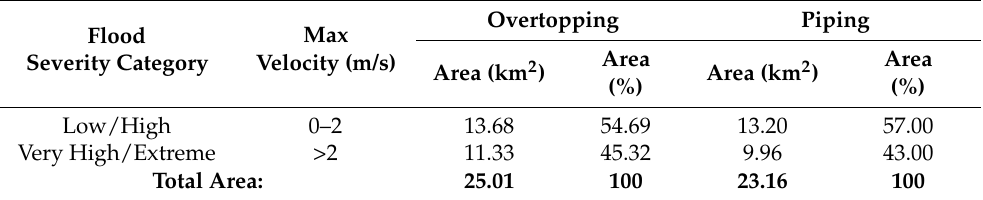
Table 9. Flood severity classes for maximum water velocity and the inundated area per class.